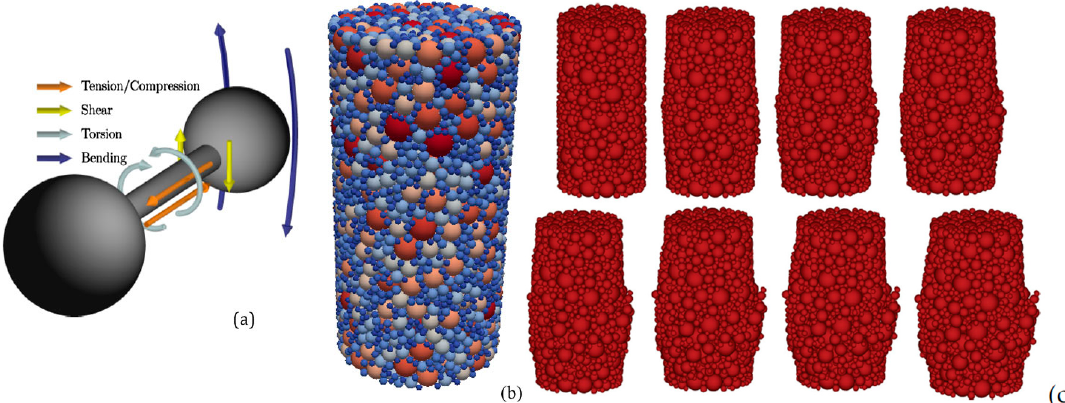
Figure 15. ( a ) Bond interaction scheme between two particles; ( b ) particle size distribution; ( c )